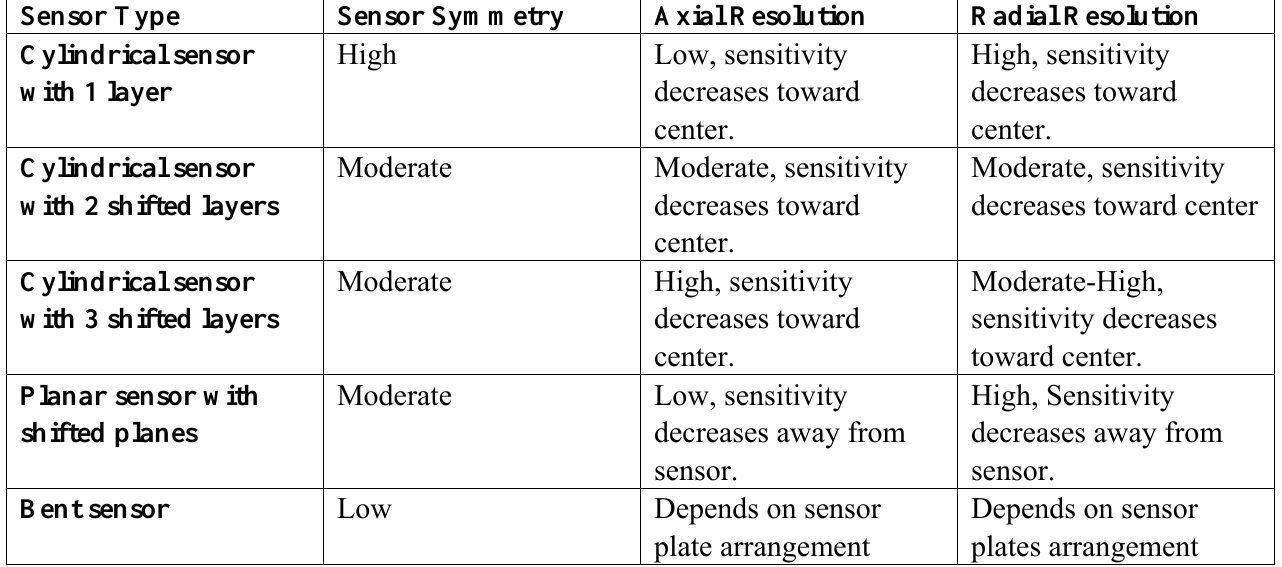
Table 2. Comparison of different sensor geometries in terms of symmetry, axial resolution and radial